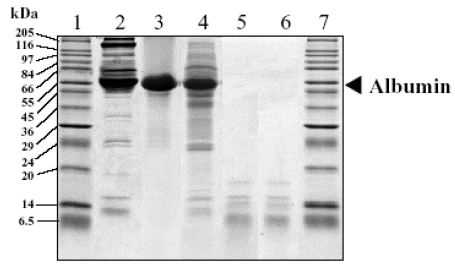
1-D SDS-PAGE analysis of crude plasma (lane 2), commercially prepared HSA (lane 3), SPE eluate (lane 4), UF filtrate (lane 5), and UF-SPE eluate (lane 6). Molecular weight markers (6.5–205-kDa) were electrophoresed in lanes 1 and 7. 20 μg total protein was applied per lane and visualized by coomassie blue staining. The albumin band is shown. See Figure 1 legends for details regarding the SPE, UF and UF-SPE protocols.